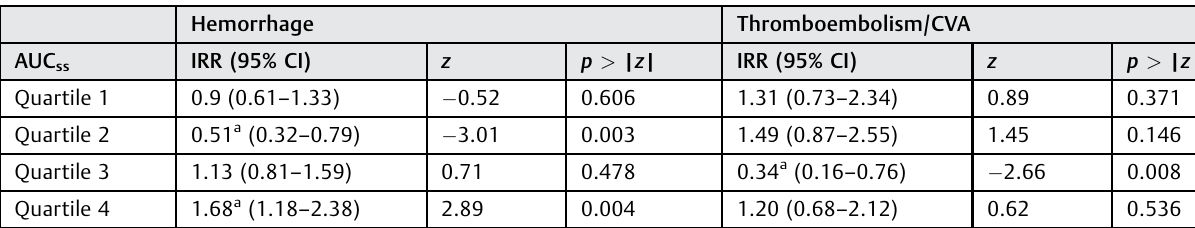
Table 3 Poisson regression expressed as adjusted incidence rate ratios (IIRs) and 95% con fi dence interval (95% CI) of